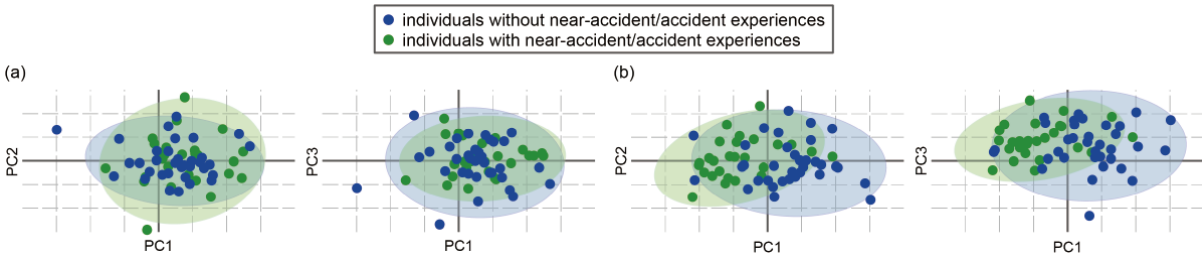
Figure 3. Principal component analysis plots using (a) cognitive assessment variables and (b) speech features, with confidence interval ellipsoid set to 0.95. PC: principal